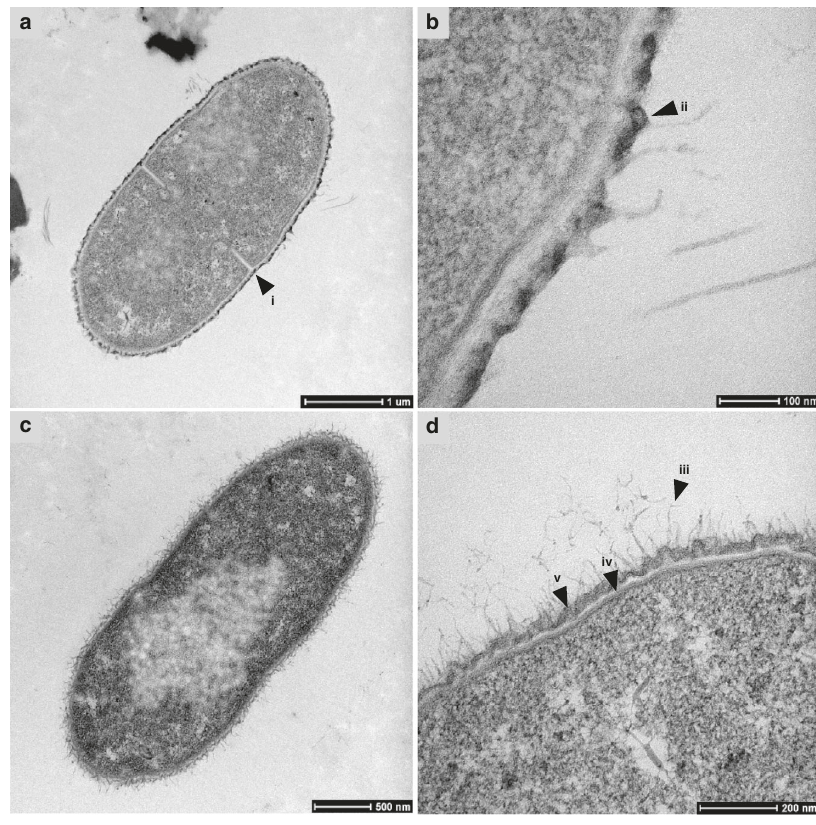
fi mbriae or outer surface material; (iv) cytoplasmic membrane; (v) outer mem- brane. The scale bars indicate different distances for each panel. TEM was per- formed onlyonsample3,andtheseimageswereselected toillustratethedifferent features observed.